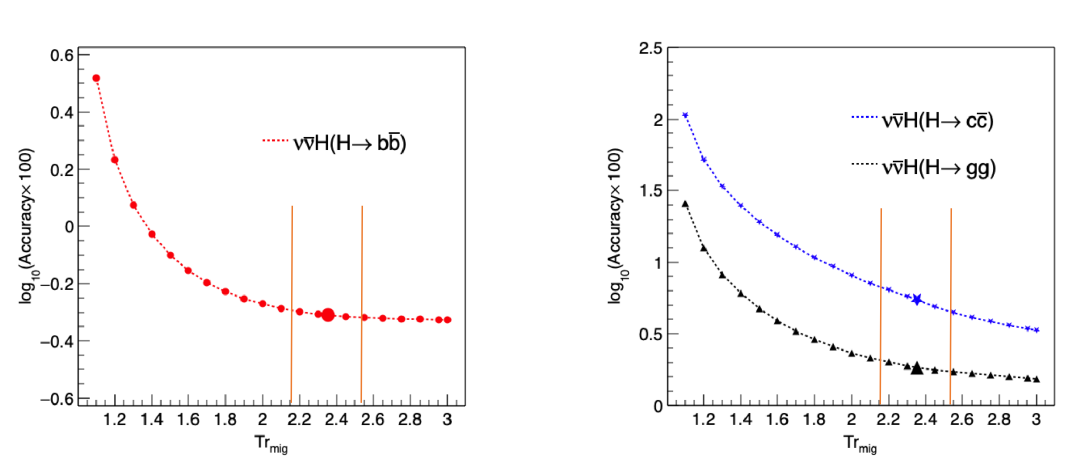
¯ Figure 11 . The dependence of ν ¯ νH ( H → b b/c ¯ c/gg ) signal strength accuracy on flavor tagging performance is shown in this figure, the left plot is for ν ¯ νH ( H → b ¯ b ) , and the right plot is for ν ¯ νH ( H → c ¯ c/gg ) . The bigger markers correspond to the results of the CEPC baseline detector. When the key vertex detector parameters, including inner radius, material budget, and spatial reso- lution, are changed by a factor 0.5/2 from the baseline design (the geometry we used in this